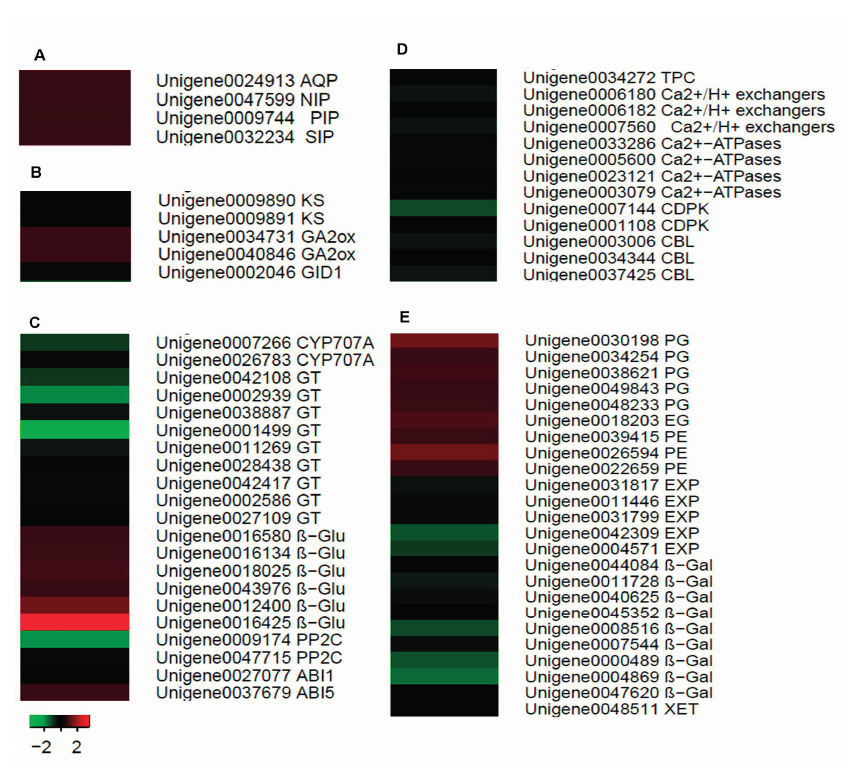
Figure 6. Heat map diagram of candidate genes for fruit cracking in Litchi chinensis Sonn. The DEGs annotated in pathways related to water transport ( A ); gibberellin (GA) metabolism ( B ); abscissic acid (ABA) metabolism ( C ); Ca transport ( D ); cell wall metabolism ( E ) are